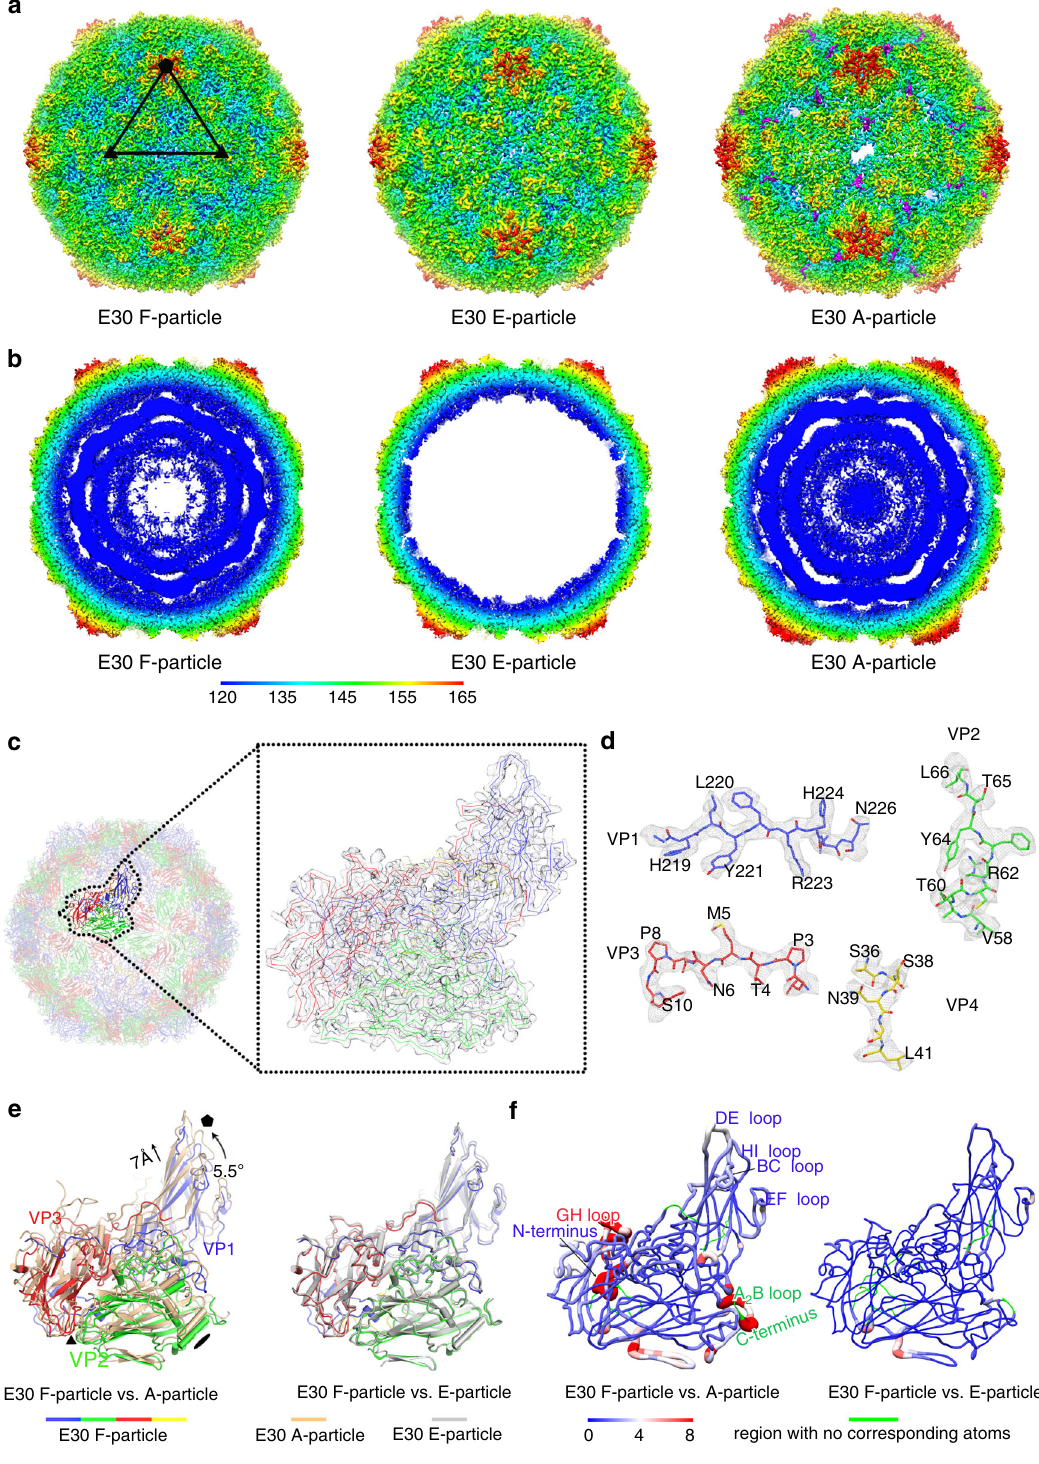
increase in radius with a maximum diameter of ~345 Å along the fi vefold axis (Fig. 1a, b). The expansion of the A-particle re fl ects tectonic movements in the particle, forming perforations at the icosahedral two-fold axes, accompanied by a ~5.5° counter- clockwise rotation of the protomeric unit near the threefold axis and a ~7 Å shift away from the two-fold axis of the protomer unit (Fig. 1e). Superposition of the asymmetric units (protomers) veri fi es the similarity in capsid structures of the F- and E-particles